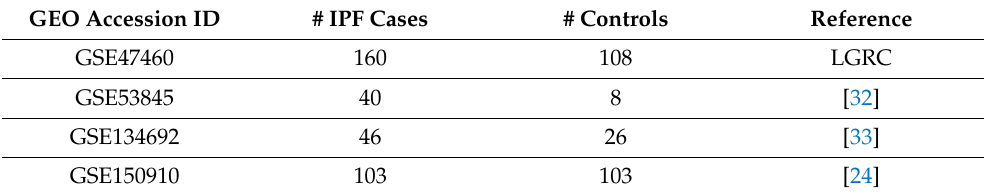
Table 5. List of GEO datasets used in the WGCNA consensus analysis (including the validation